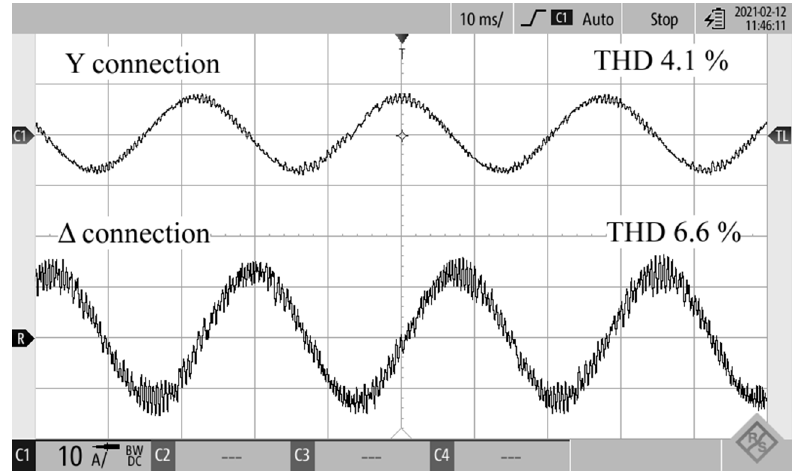
Figure 13. Line current comparison for a star and delta winding connection; reference speed 1000 RPM, reference stator flux 1 Wb, load torque 15 Nm.